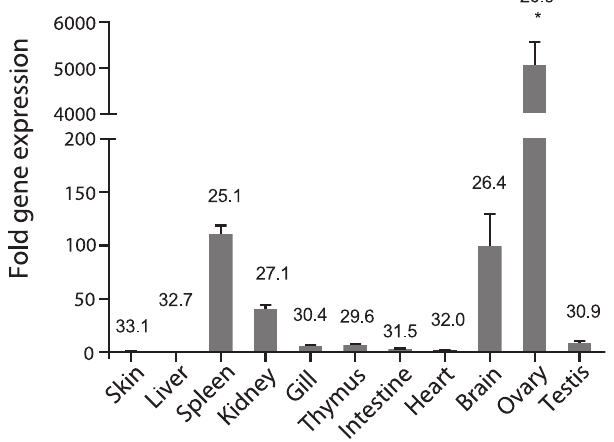
Figure 4. Tissue distribution of Eomes expression in Atlantic salmon. Expression of salmon Eomes in different organs as detected by real-time PCR. Gene expression data were normalized to EF-1 a expression using skin as a calibrator. Bar represents the mean 6 S.E.M (n=6). Asterisk (*) above the bar shows significant difference ( P , 0.05) compared with the organ that showed the lowest expression (skin). The value above the bars shows average real-time CT values of six fish.